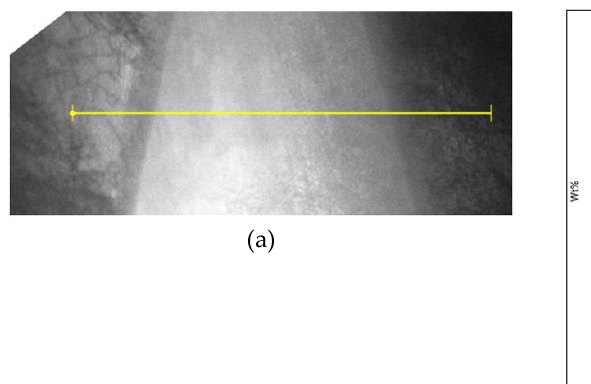
Figure 4. Structure scans of individual pieces sintered at 1500 °C for: 60 min ( a ); 90 min ( b ); 120 min ( c ); 150 min ( d ); 180 min ( e ). Materials 2020 , 12 , x FOR PEER REVIEW